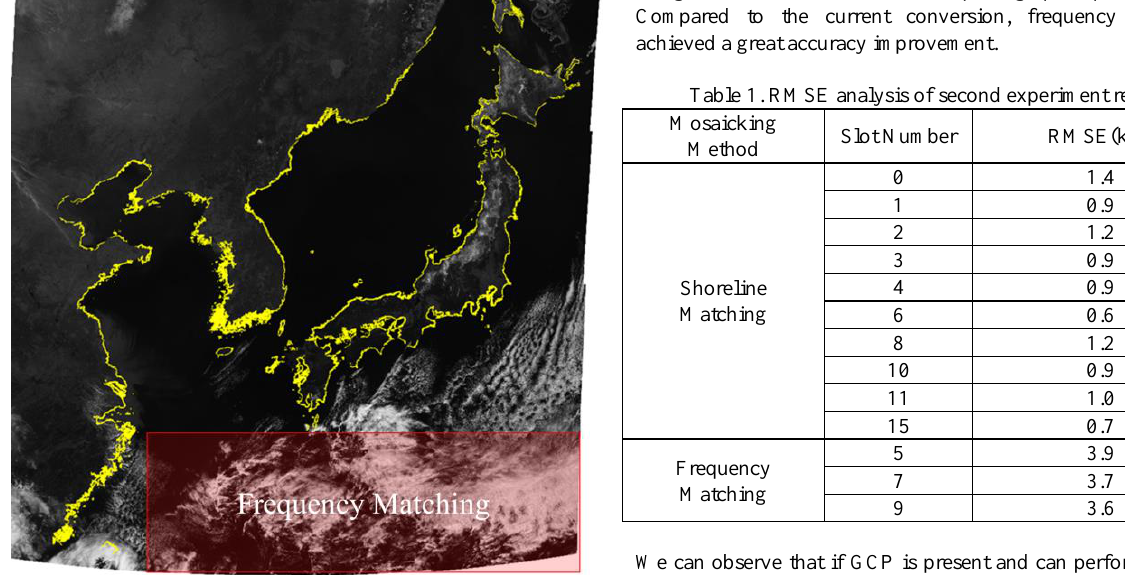
Figure 10. The result of first